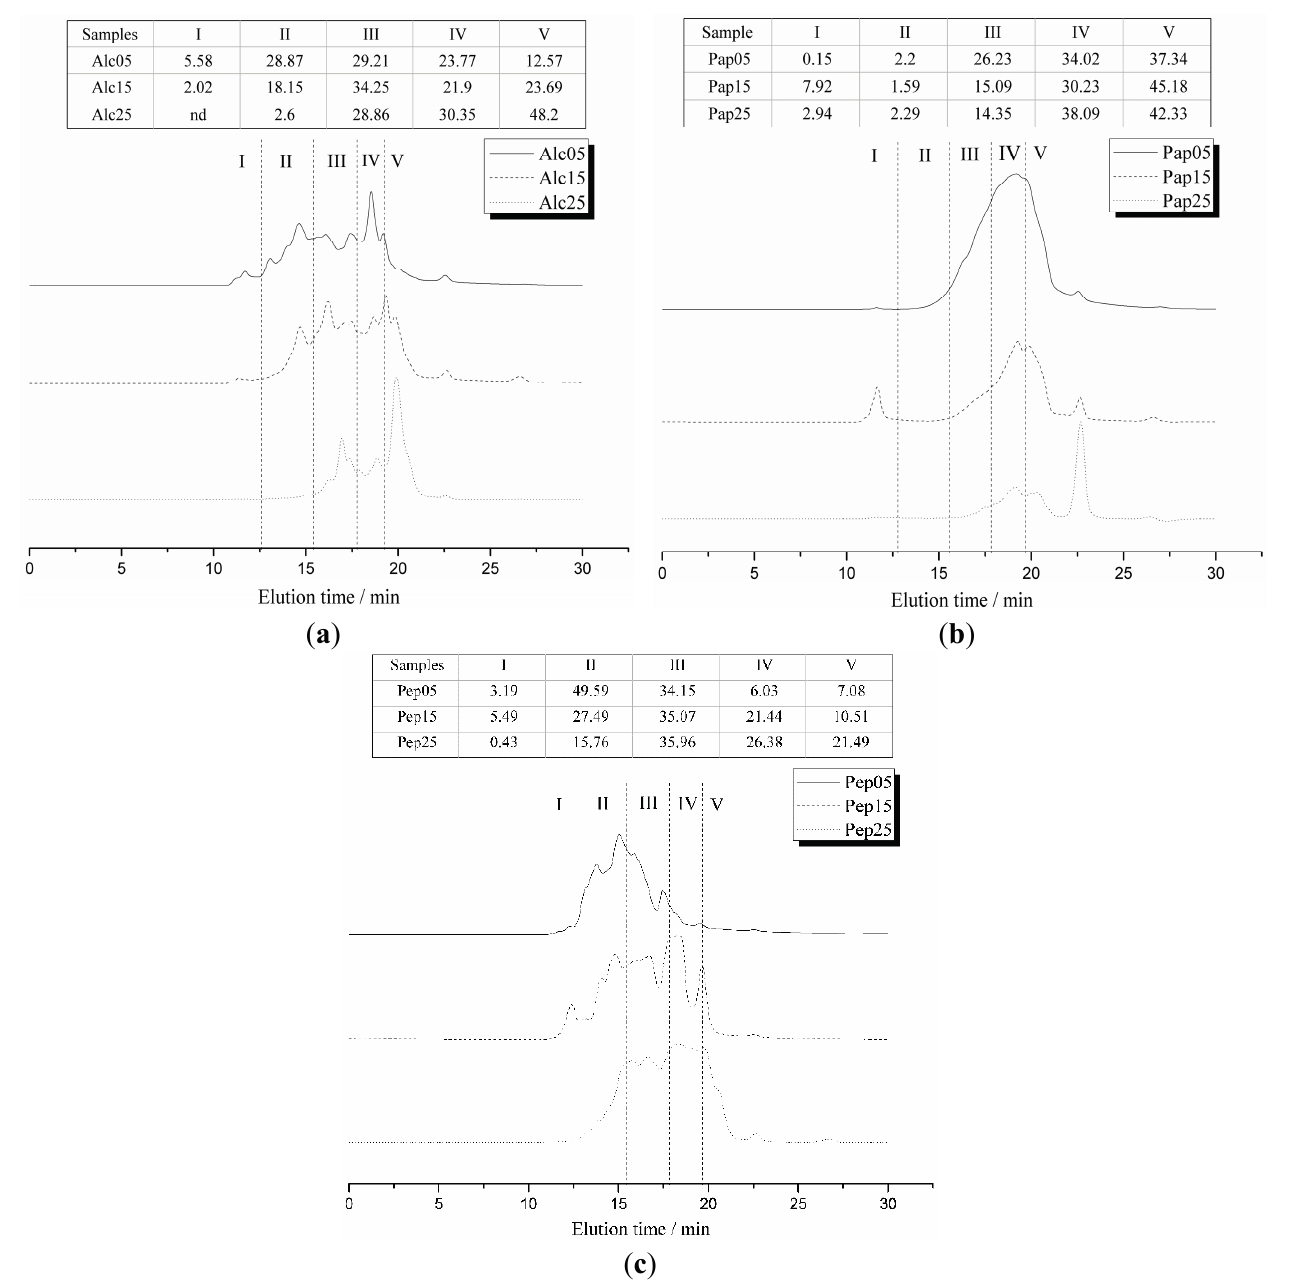
Figure 3. SEC-HPLC profiles of TCPs with different DH obtained by enzymatic hydrolysis with alcalase ( a ), papain ( b ) and pepsin ( c